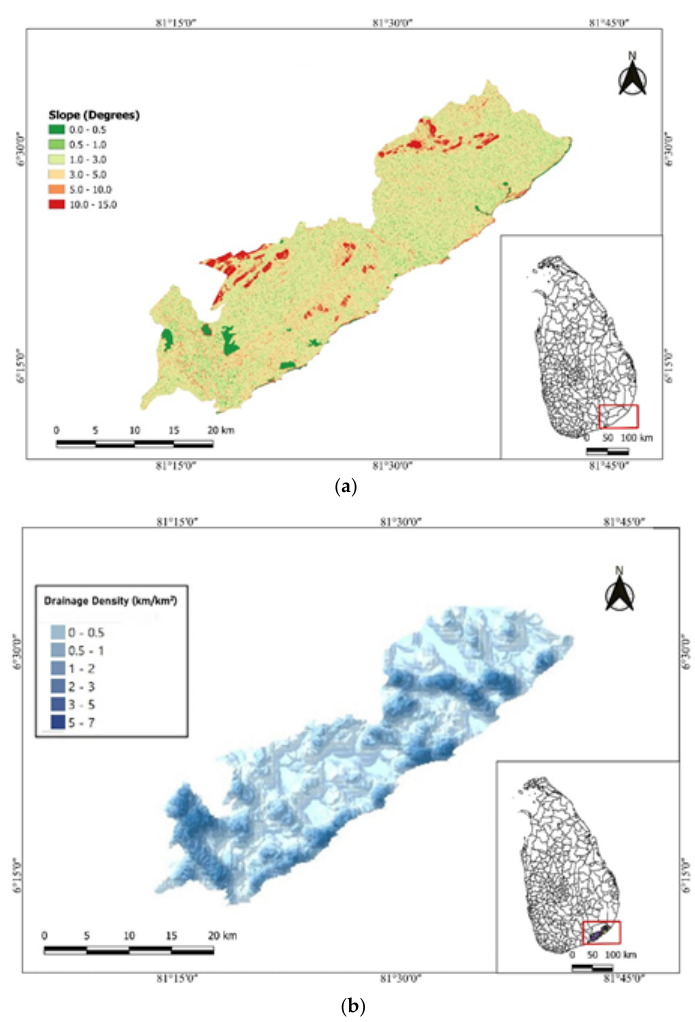
Figure 6. ( a ) Slope map, and ( b ) Drainage density map of Tissamaharama